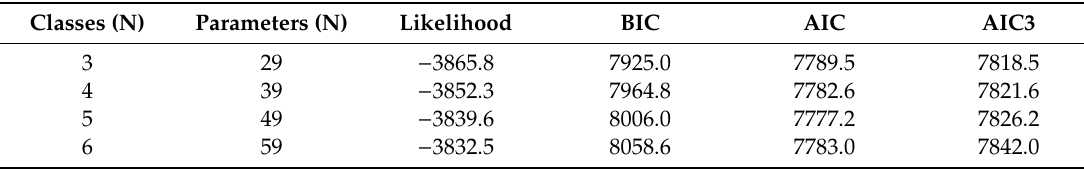
Table 2. Parameters of fit in latent class analysis.